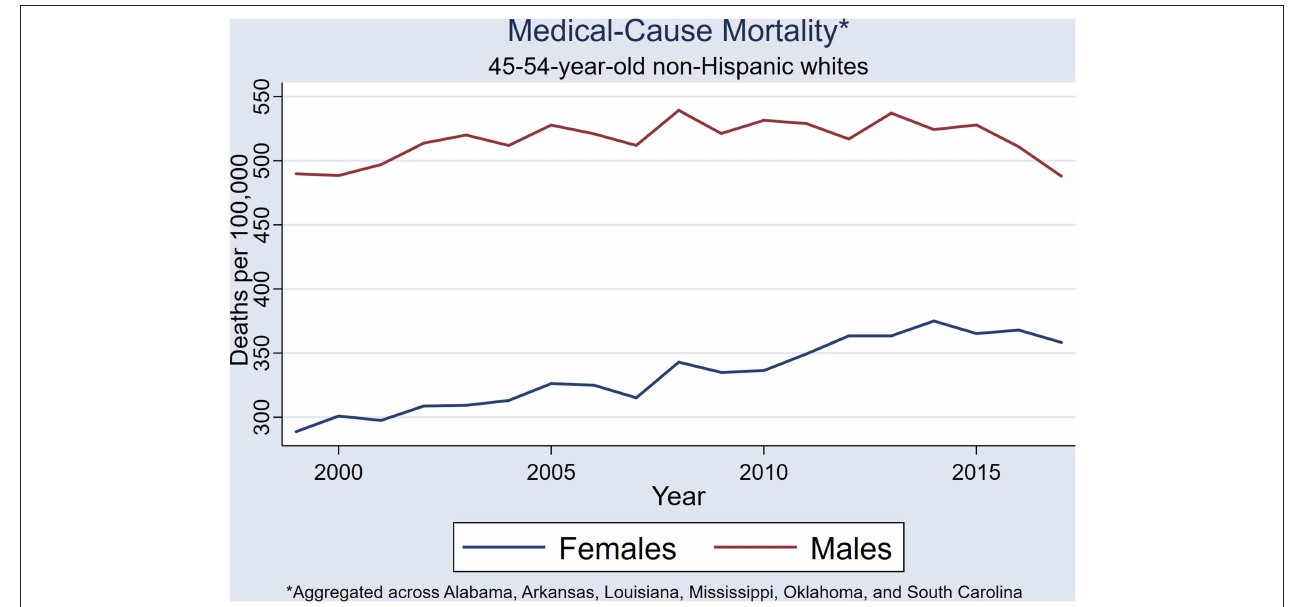
TABLE 1 | Annual hydrocodone sales time series Spearman rank correlations between the six states, using second differences (2000–2017). Year (test for trend) AL AR* LA MS OK* SC